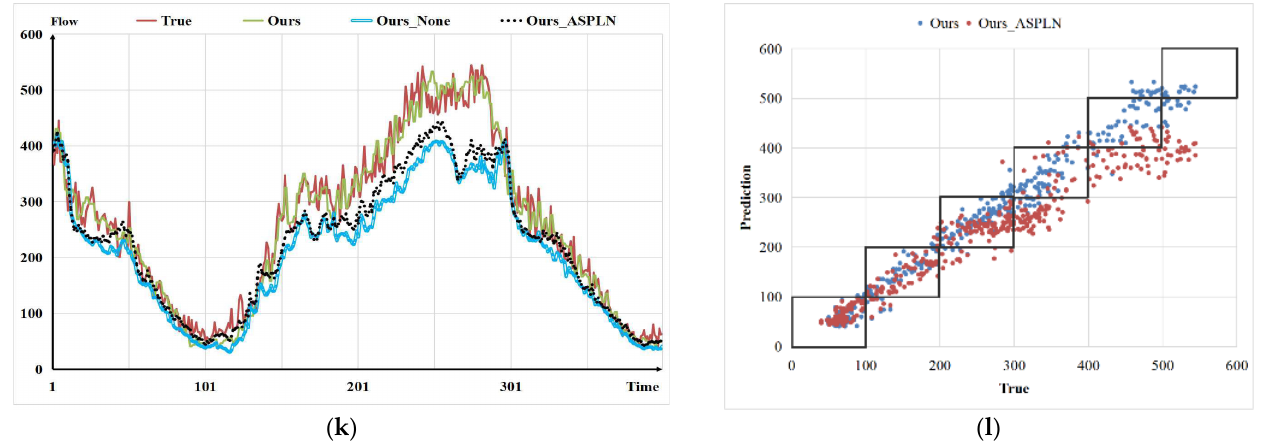
Figure 14. The model prediction results retain only one complex network characteristic compared with the GSTNCNI prediction results. ( a ) Comparison between GSTNCNI and Ours_DC; ( b ) Scatter diagram of GSTNCNI and Ours_DC prediction results; ( c ) Comparison between GSTNCNI and Ours_CC; ( d ) Scatter diagram of GSTNCNI and Ours_CC prediction results; ( e ) Comparison be- tween GSTNCNI and Ours_CTC; ( f ) Scatter diagram of GSTNCNI and Ours_CTC prediction results; ( g ) Comparison between GSTNCNI and Ours_PS; ( h ) Scatter diagram of GSTNCNI and Ours_PS prediction results; ( i ) Comparison between GSTNCNI and Ours_BC; (j) Scatter diagram of GSTNCNI and Ours_BC prediction results; ( k ) Comparison between GSTNCNI and Ours_ASPLN; ( l ) Scatter diagram of GSTNCNI and Ours_ASPLN prediction results;